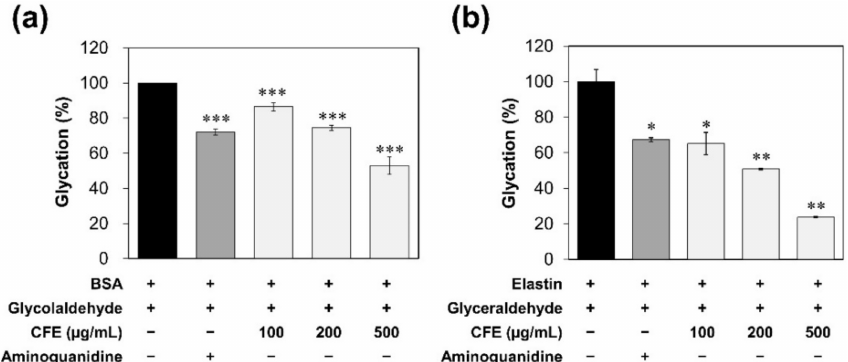
Figure 2. The effects of CFE on aldehyde-derived glycation. ( a ) Fluorescence intensity of AGEs in GA-modified BSA for 5 days of incubation. These data were represented as a percentage (%) of the fluorescence intensity of the sample compared to the control (BSA+/GA+). ( b ) Glycation degree of elastin glycated by glyceraldehyde. Statistical significances were represented as follows: *, p < 0.05; **, p < 0.01; ***, p < 0.001 compared to control